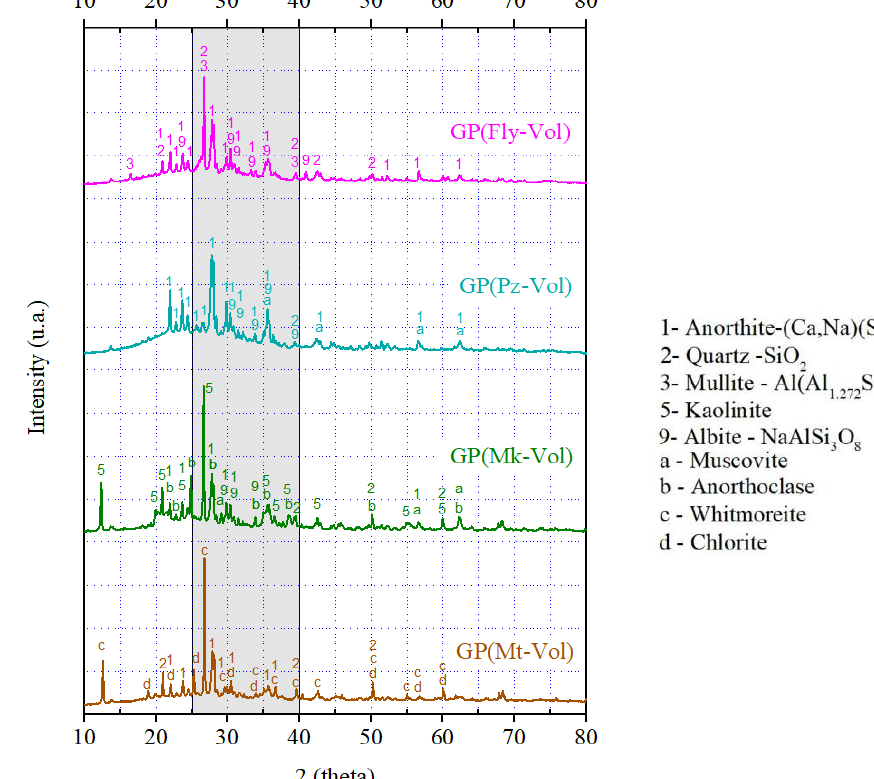
Figure 2. XRD patterns of geopolymers based on volcanic ash with the other raw materials (Fly, Pz, Mk, and Mt).